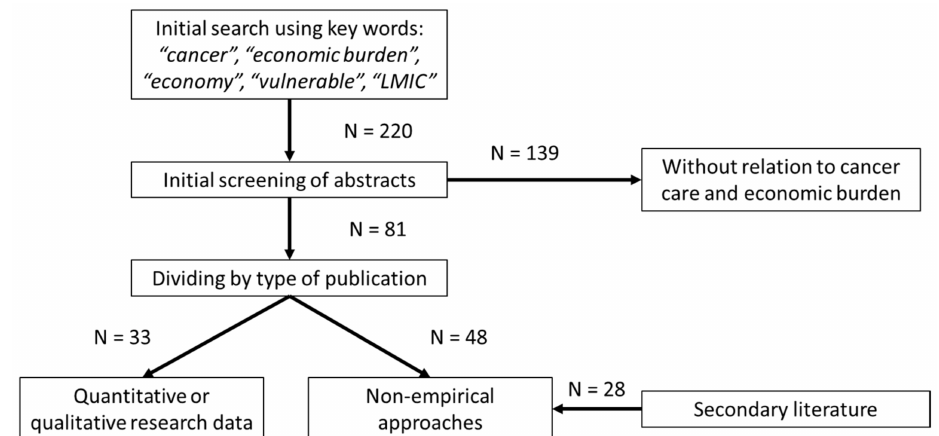
Figure 1. Literature search and evaluation strategy (CONSORT